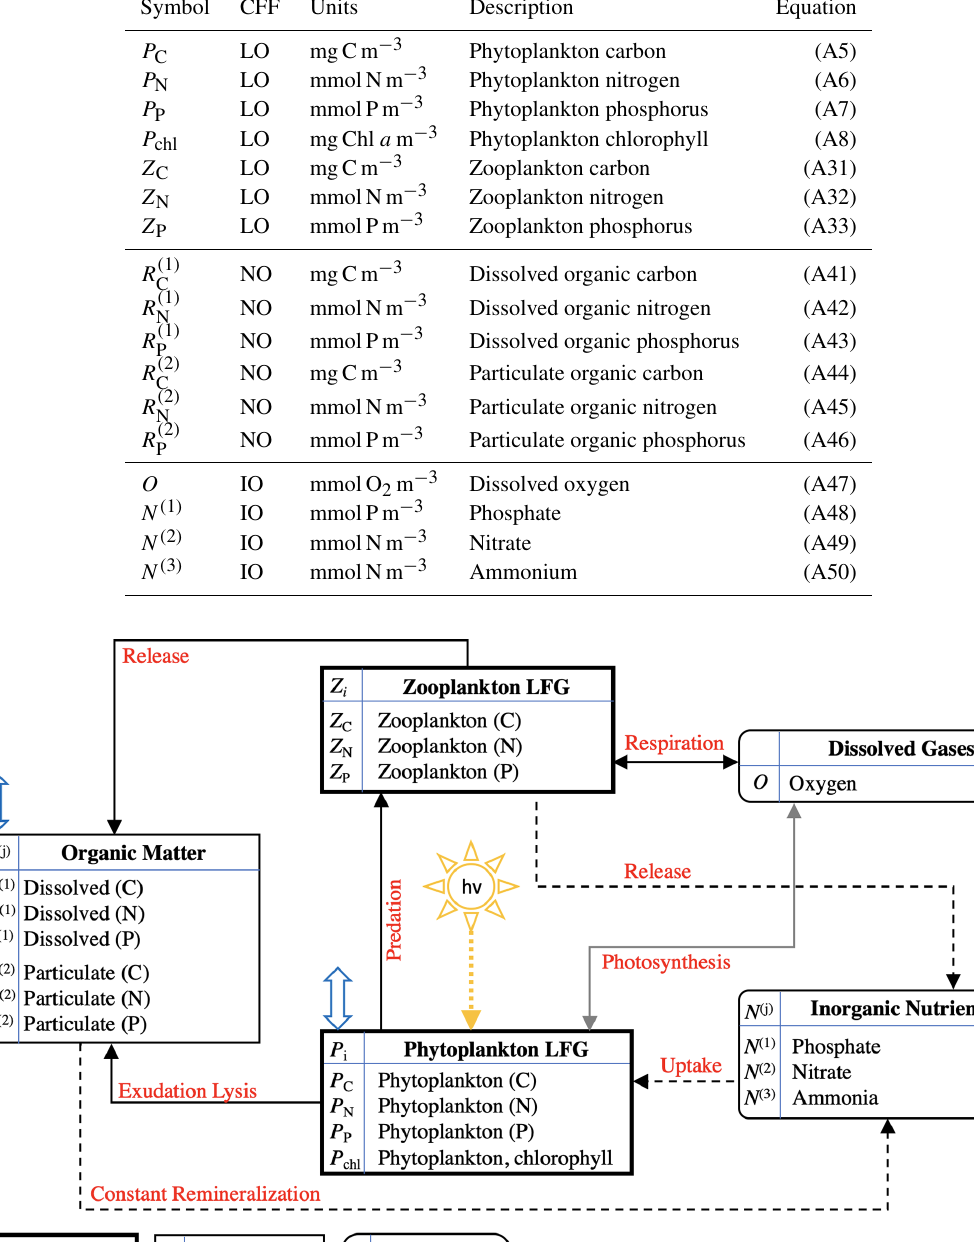
Table 1. Notation used for the 17 state variables in the BFM17 model, as well as the chemical functional family (CFF), units, description, and rate equation reference for each state variable. CFFs are divided into living organic (LO), non-living organic (NO), and inorganic (IO) families.